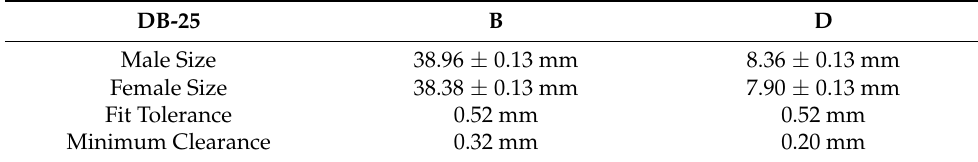
Figure 13. The mating face of DB-25 connector. ( a ) Male (peg/plug). ( b ) Female (hole/receptacle). Table 2. DB-25 size and tolerance.